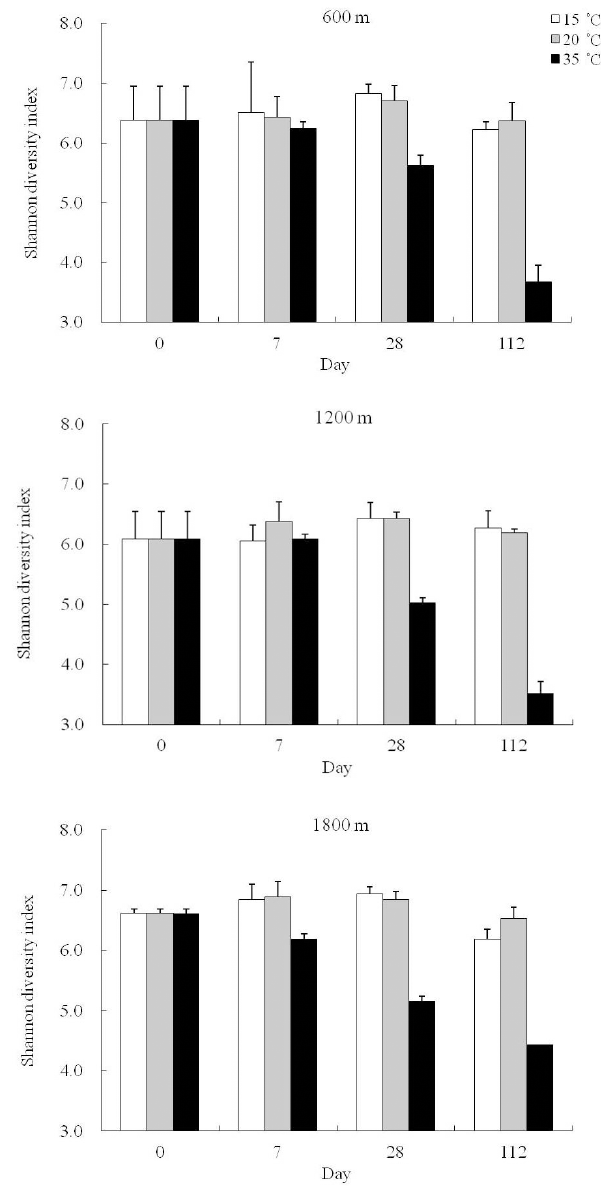
Figure 3. Changes in bacterial diversity of soil community at 600, 1200, and 1800m incubated at different temperatures.